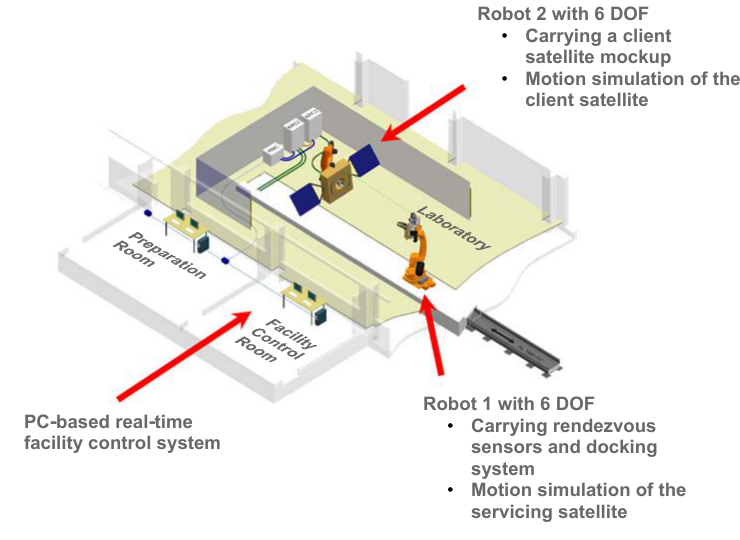
Figure 3: Possible setup of an RvD simulation with a client and a servicing satellite represented by the robots.